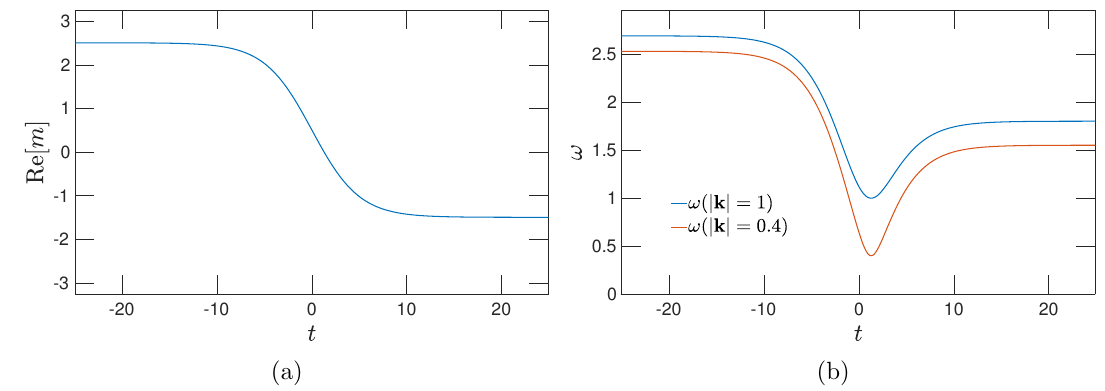
Figure 2. Left panel (a): the real part of the mass pro(cid:12)le m ( t ) of equation (3.15), with parameters m 1 = 0 : 5 + 0 : 005i, m 2 = 2 and (cid:28) w = 5, in arbitrary units. Right panel (b): the positive energy p eigenvalue ! k ( t ) = k 2 + j m ( t ) j 2 with the same mass function as in the left panel and with both j k j = 1 and 0 :